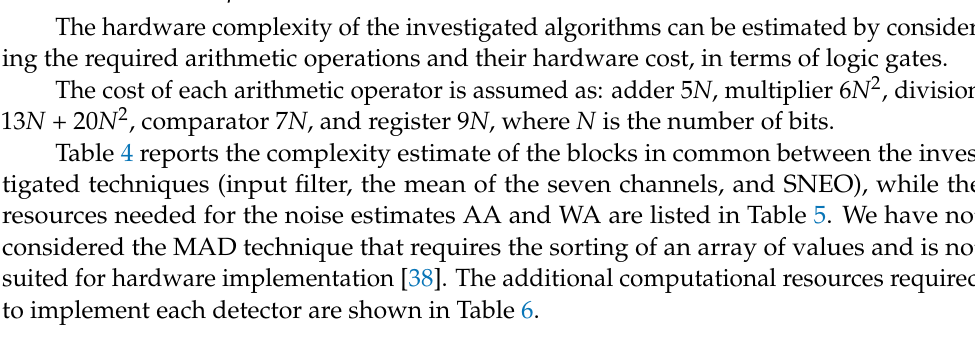
Table 2. Detection performances of pre-norm algorithm at different firing rates at SNR = 0 dB (C = 7). MAD